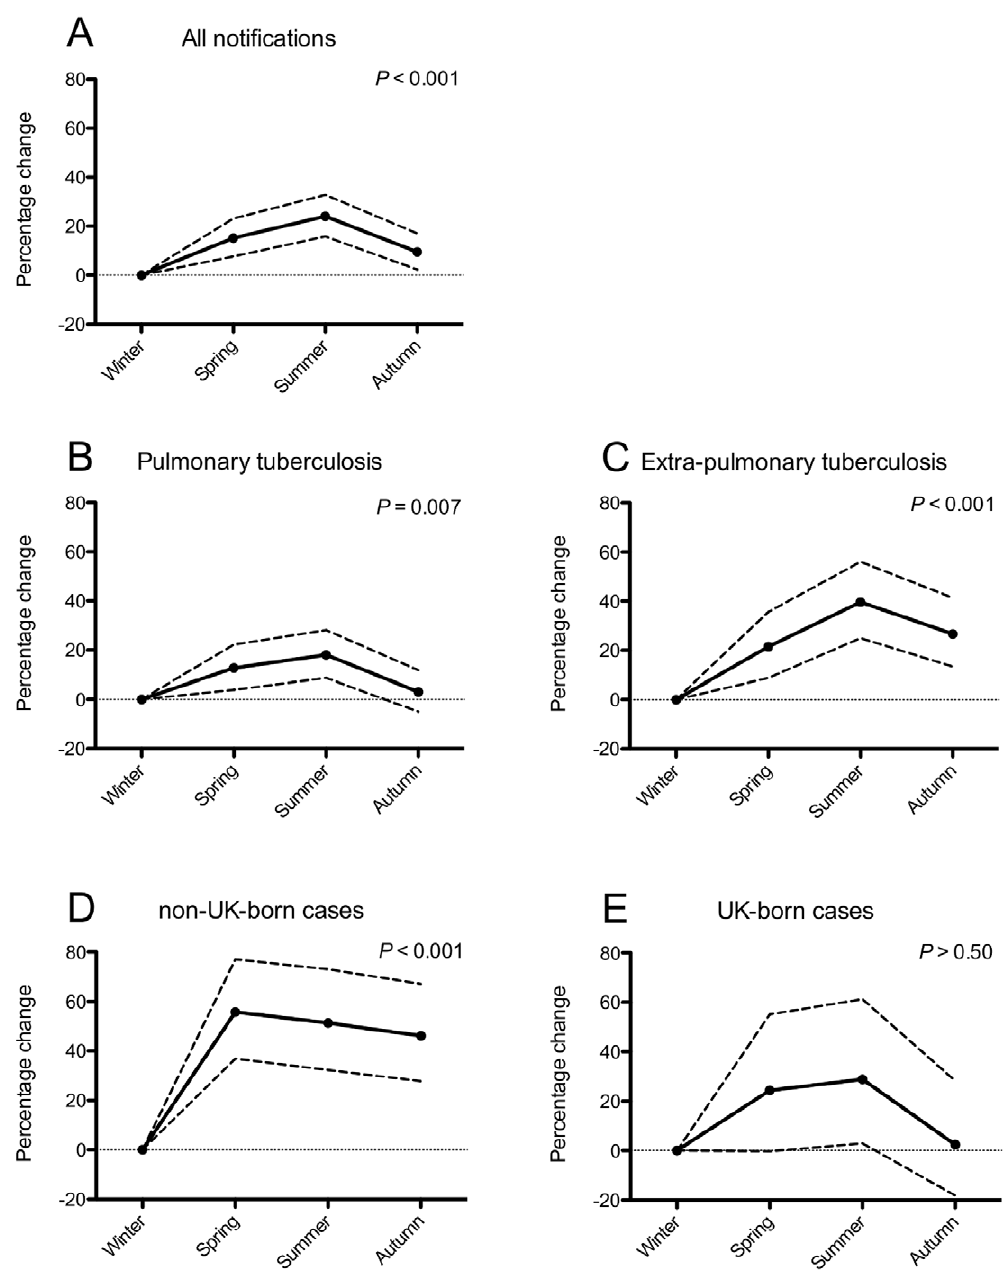
Figure 2. Seasonal difference in tuberculosis notifications. Note.– The solid lines show the percentage of excess notifications compared to winter, the interrupted lines are the 95% confidence intervals. A. all notifications; B. pulmonary tuberculosis only; C. extra-pulmonary tuberculosis only; D. Non-UK-born cases only; E. UK-born cases only.